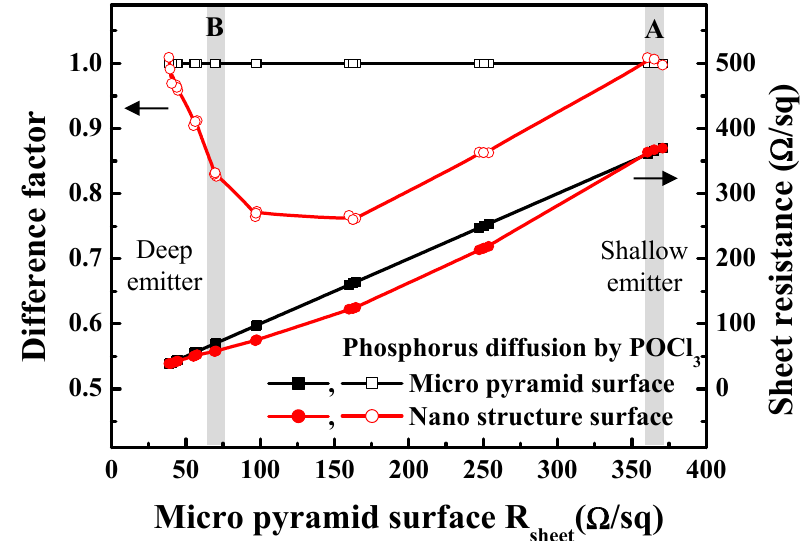
Figure 4. Change in emitter sheet resistance of micro-pyramid structure and nanostructure, according to the doping process condition.